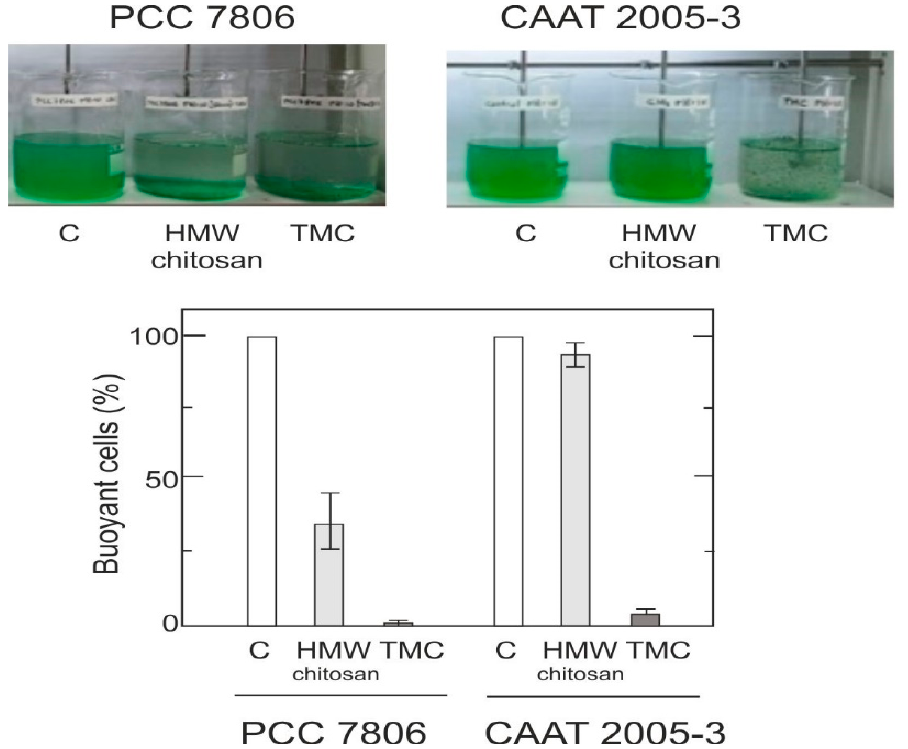
Figure 3. Removal of M. aeruginosa cells by HMW chitosan and TMC in a Jar ‐ Test experiment. The capacity of 5 mg L − 1 HMW chitosan at pH 10 to remove cells of two M. aeruginosa strains (PCC 7806 and CAAT 2005 ‐ 3) was assayed in a Jar ‐ Test experiment.